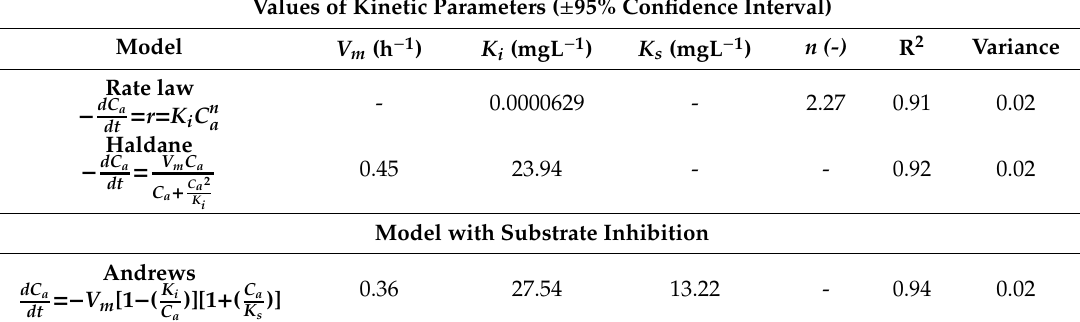
Table 1. Estimated kinetic parameter values for the models for NH 4 -N degradation, a rate limiting step in nitrification.